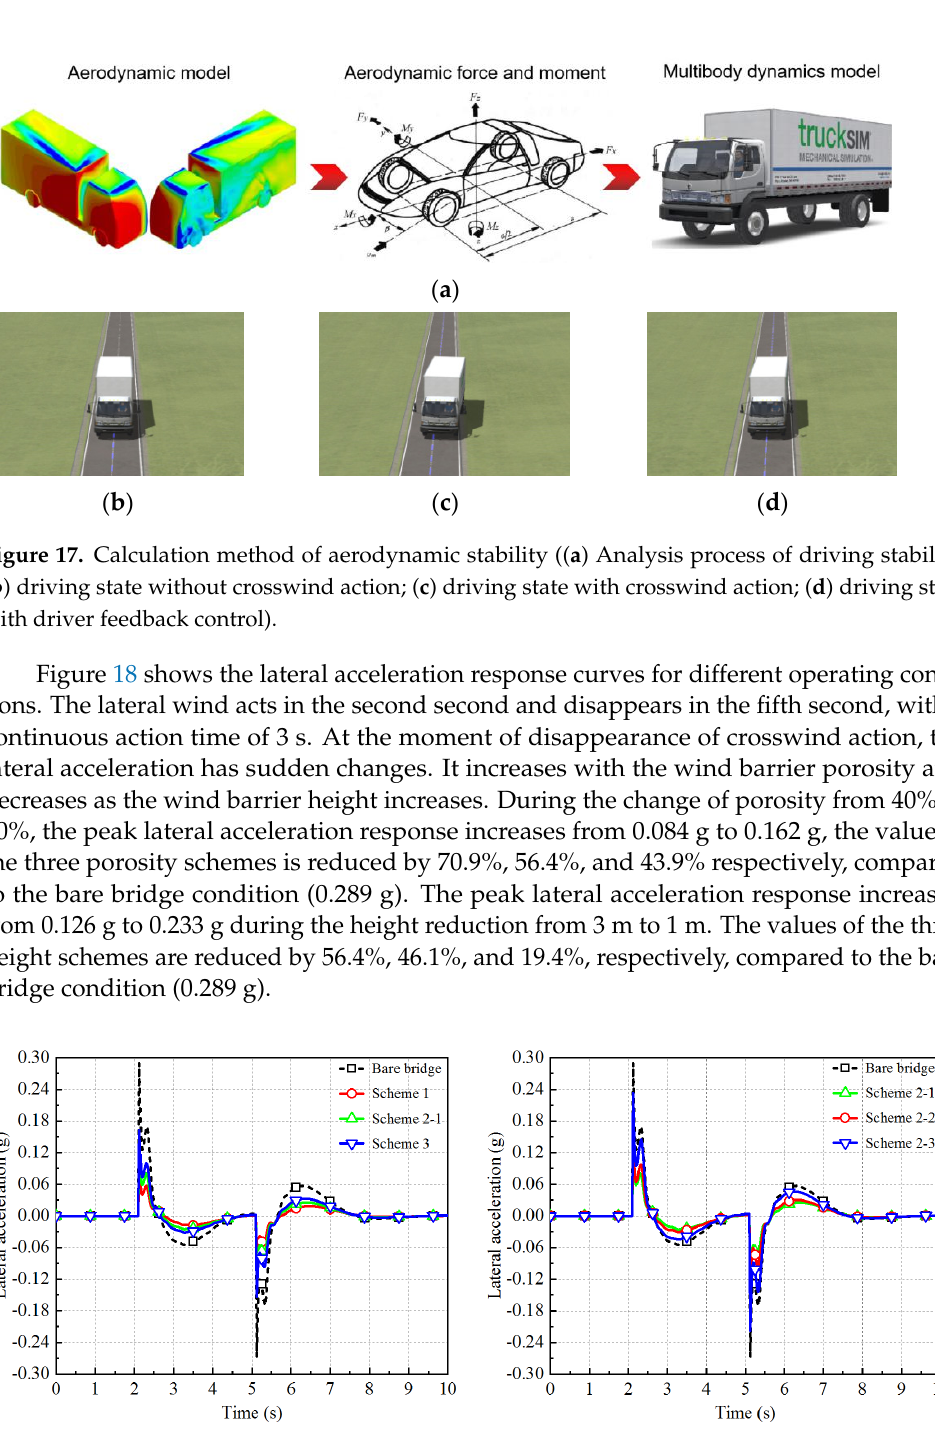
( b ) Figure 19. Yaw rate with different bridge wind barriers (( a ) Different porosity scheme; ( b ) Different height scheme). Under the crosswind action, the van has lateral and yaw movement along the cross- wind direction, deviating from the predetermined straight-line driving trajectory. Then the lateral displacement reaches a maximum in the duration act of the crosswind approx- imately 2 s and will gradually return to the predetermined driving route after the driver operation, as shown in Figure 20. The lateral displacement increases with the porosity and increases as the height of the wind barrier decreases. As the porosity rate increases from 40% to 60%, the peak lateral displacement increases from 0.226 m to 0.367 m. Compared to the bare bridge condition (0.598 m), the three porosity rate schemes decrease by 62.2%,